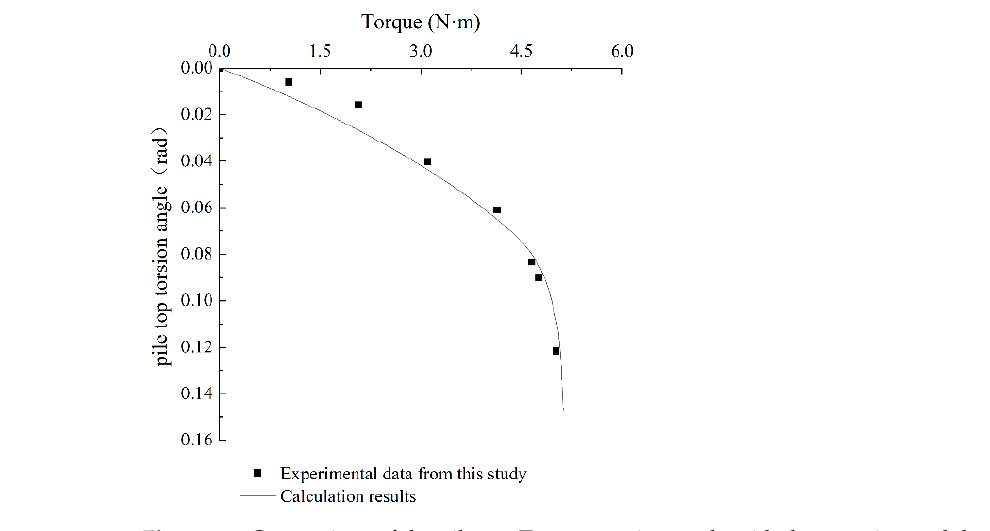
Figure 10. Comparison of the pile top Torque–torsion angle with the experimental data of this study under V → T loading path.